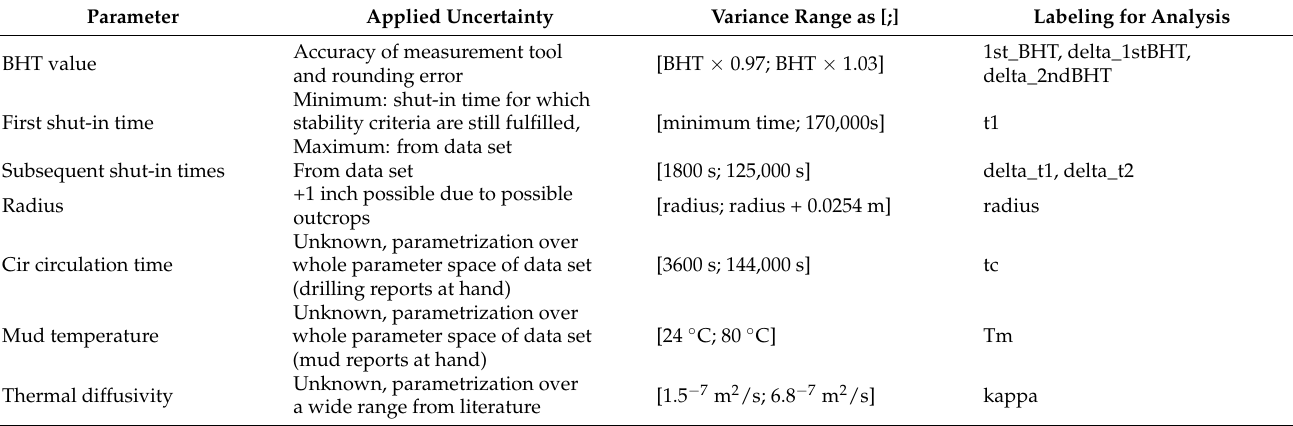
Table 4. Applied ranges for all input parameters for the uncertainty analysis. The last column lists the respective input parameters with their individual